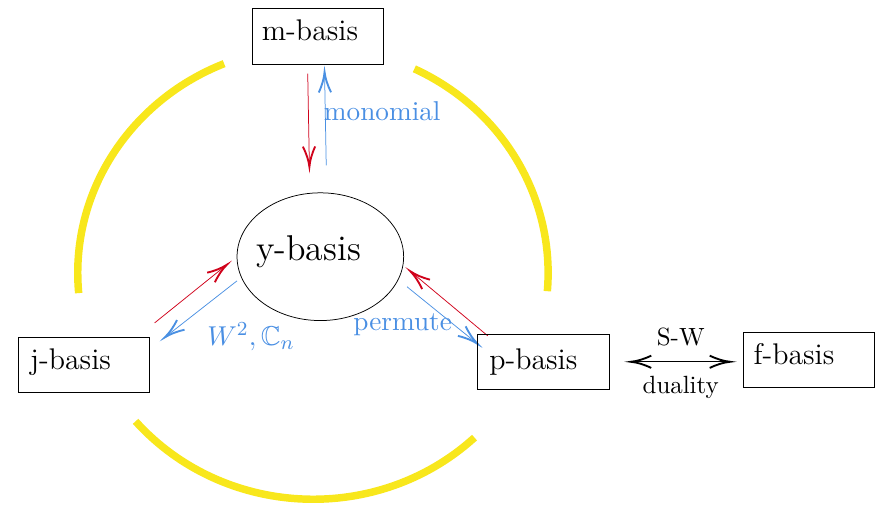
Figure 1 . Relations among the different bases [13]. The red arrow means that the basis can always be expressed as linear combination of the y-basis through a reduce procedure. The yellow circle indicates that the m-basis, the p-basis and the j-basis are related by linear transformations. The operators in the p-basis are tensors of the symmetric group S of SU( n ) group, where m is the number of repeated fields and n f repeated field. These two basis are connected by the Schur-Weyl